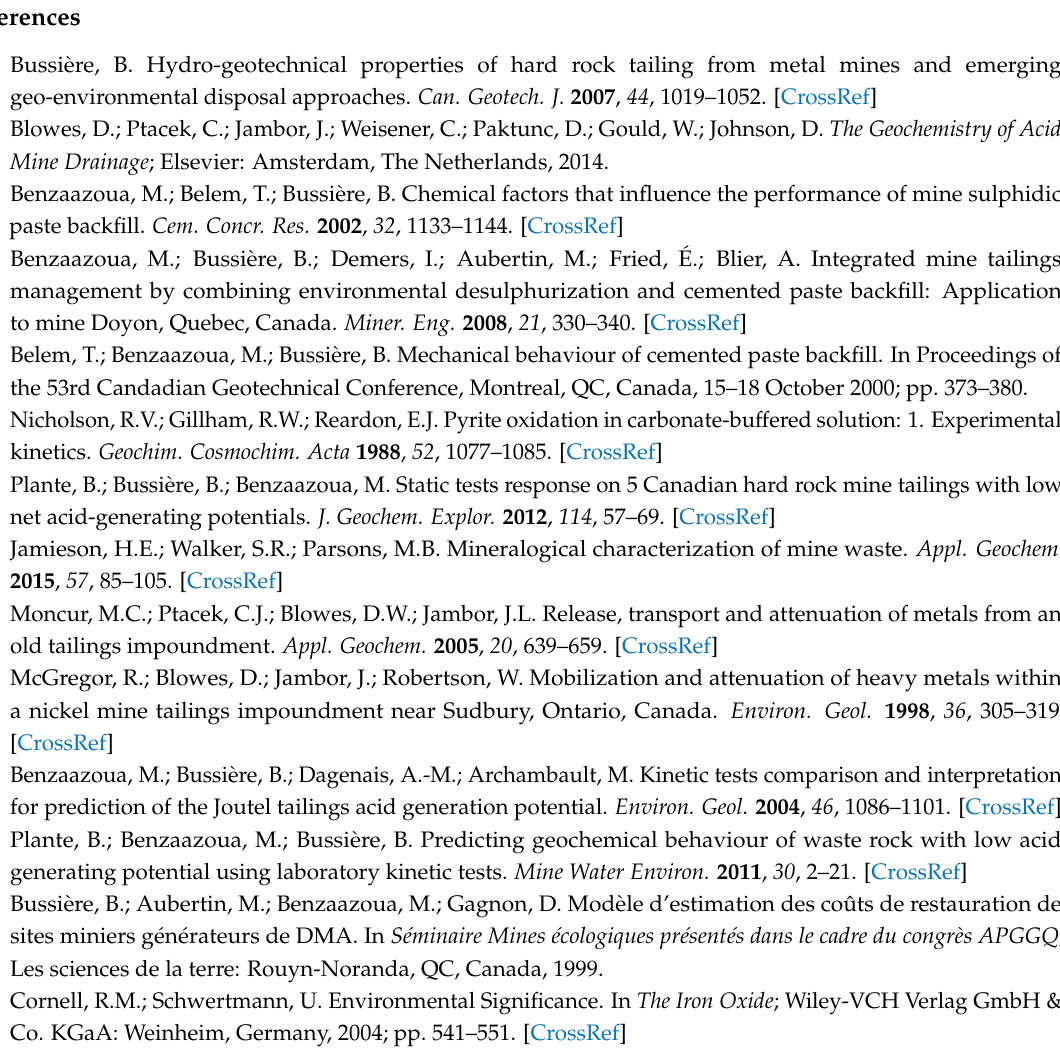
Figure S1: Graph comparing the NP calculated based on carbonate contents and NP analyzed using the Sobek method (1978) [36] as modified by Lawrence et Wang (1996) [67]. Figure S2: conceptual model illustrating the geochemical evolution of the Joutel tailings (Reproduced with permission from Elghali et al (2019) [19]; Table S1: Sampling depth of the collected